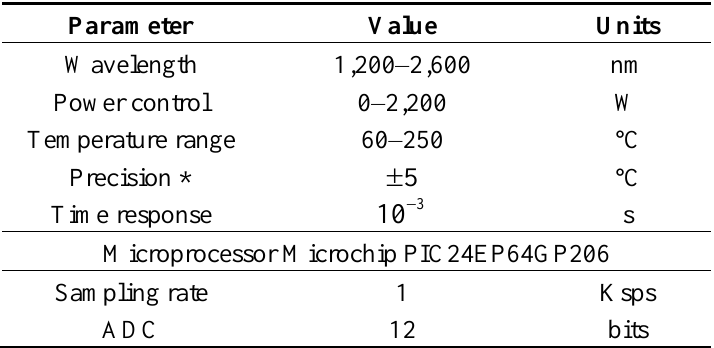
Table 1. Main system